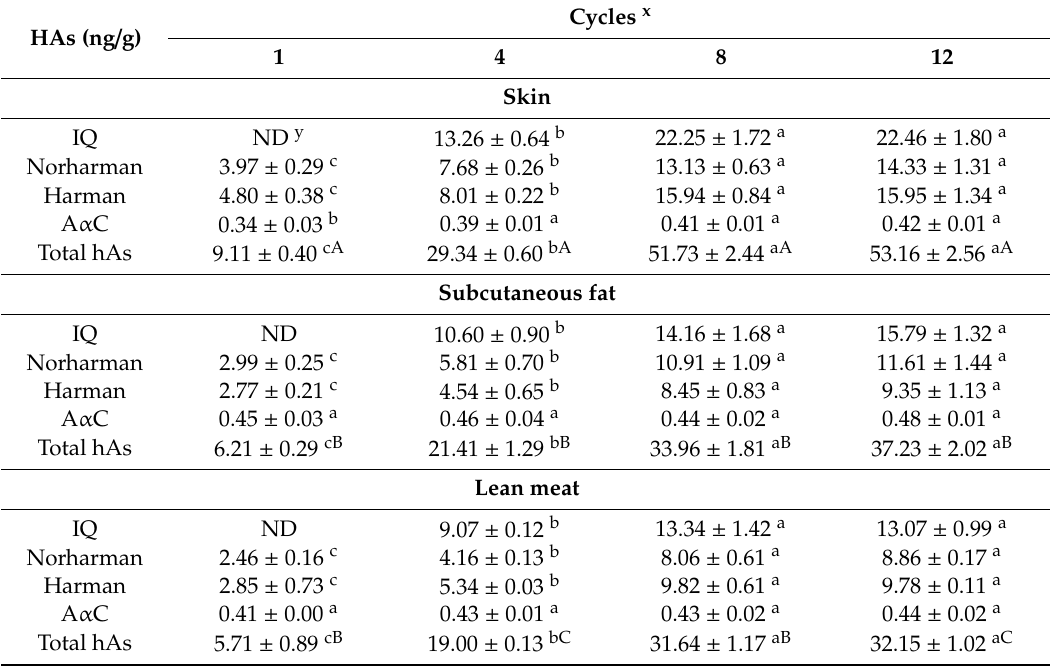
Table 2. E ff ect of the cooked cycle times of the marinated juice on the formation of the hAs in the marinated pig hock skin, subcutaneous fat and lean